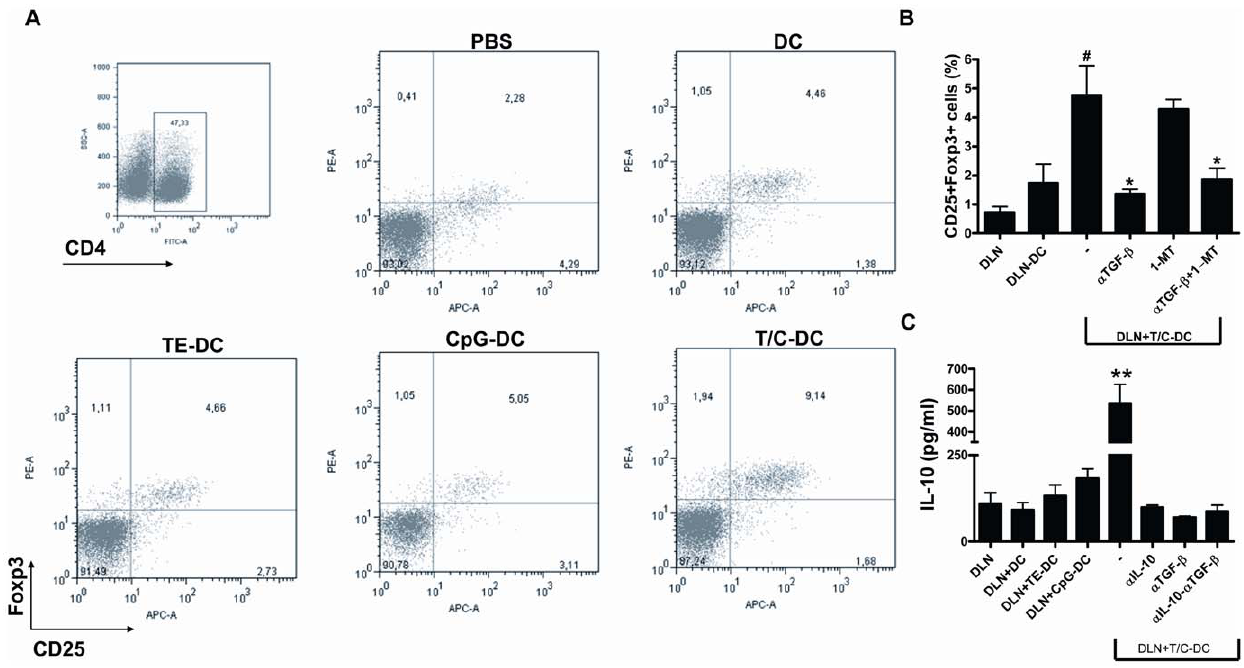
Figure 4. Enrichment of CD4 + CD25 + Foxp3 + in DLN cells by CII pulsed T/C-DC treatment. A) Cells from DLN of differentially-treated DC recipient mice were collected on day 7 of onset and stained with fluorescent antibodies for CD4, CD25 and Foxp3. Plots show the percentage of CD25 + Foxp3 + cells gated on CD4 + cells. B) Cells from DLN of CII immunized mice cultured with T/C-DC plus CII for 5 days in the presence of neutralizing antibodies against TGF- b or 1-MT. Cells were gated on CD4 + cells, and bars represent the percentage of CD25 + Foxp3 + cells. # P , 0.05 versus DLN + DC, * P , 0.05 versus DLN + T/C-DC. C) DLN cells from CII immunized mice were cultured with CII pulsed differentially treated DC in the presence of anti TGF- b and IL-10 production was analyzed by ELISA. ** P , 0.005 versus DLN + T/C-DC a TGF- b . Data are representative of two independent experiments.